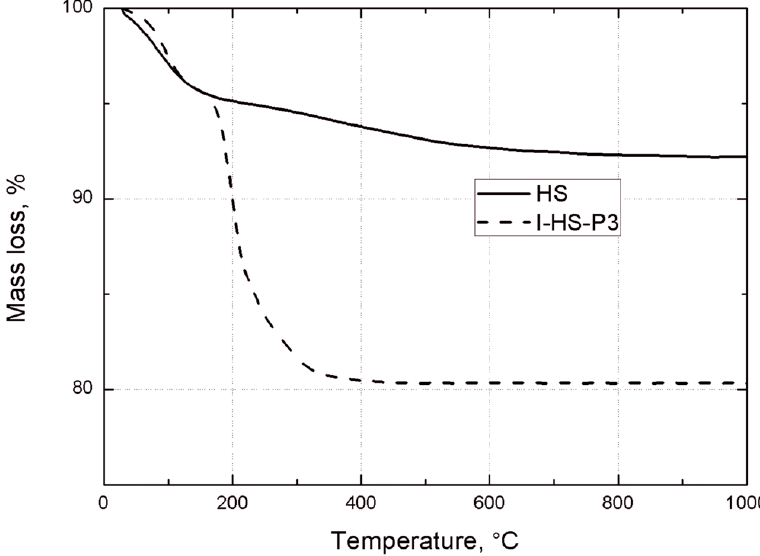
Figure 10. TGA curves of unmodified silica HS, and POSS3-modified silica I-HS-P3.